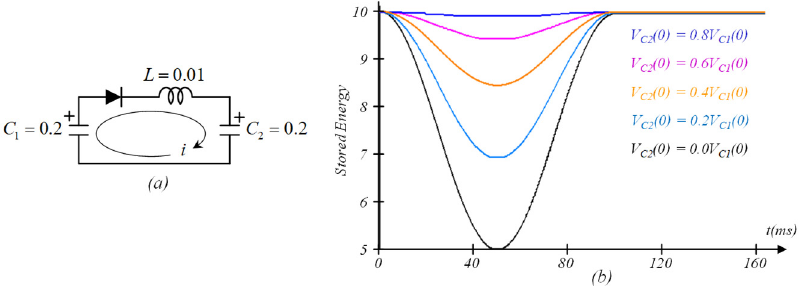
Figure 24. Basic resonant SC circuit simulated, ( a ) schematic with parameters in the simulation, ( b ) evolution of store energy during charge interchange for different values of initial voltage.